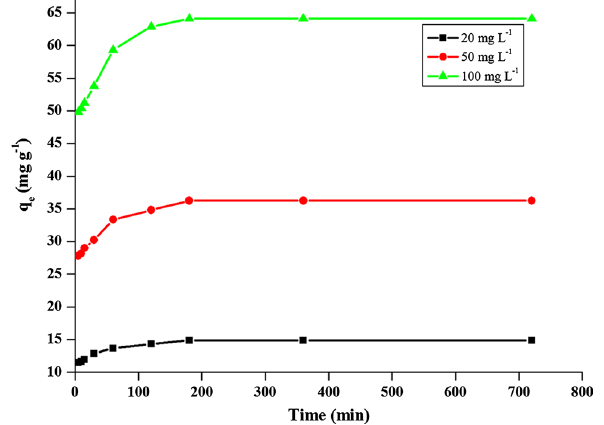
Fig. 8 Effect of doses on the adsorption of CV onto PGADP (condi- tions; CV = 20 mgL −1 ; pH = 7.3; temperature = 30 °C) Fig. 9 Effect of contact time on the adsorption of CV onto PGADP (conditions; pH = 7.3; adsorbent = 0.025 g; temperature = 30